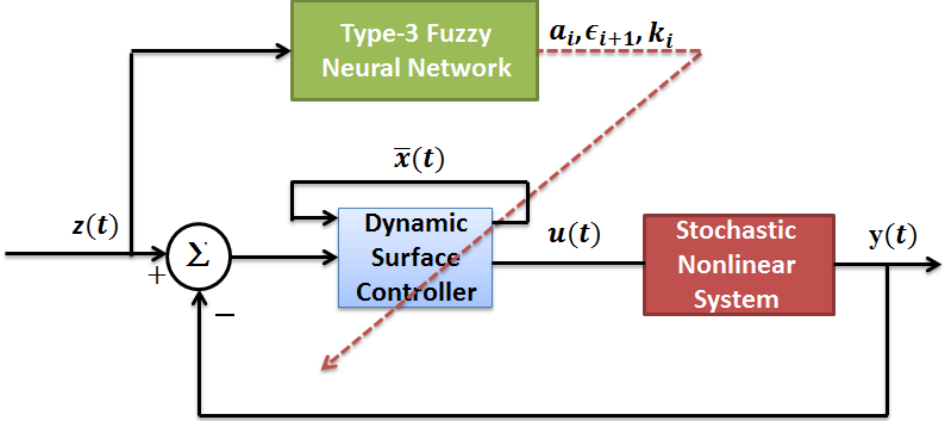
Figure 3. Block diagram of the proposed control system.